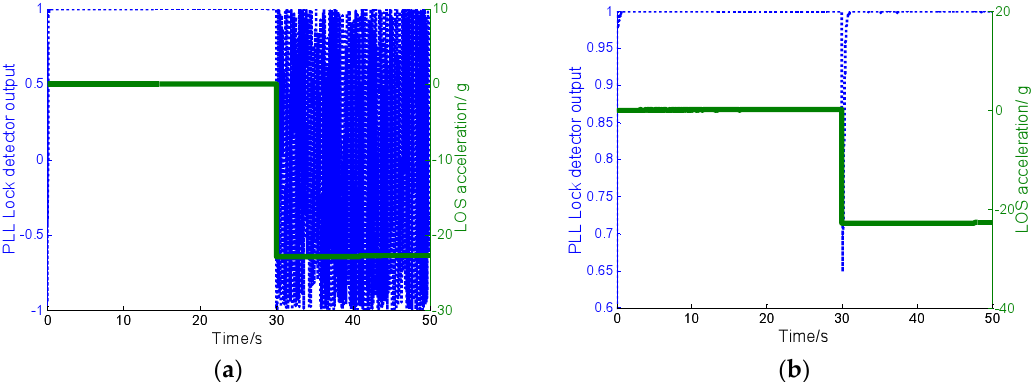
Figure 11. ( a ) PLL lock detector output of conventional ultra-tight integration. ( b ) PLL lock detector output of our proposed ultra-tight integration.